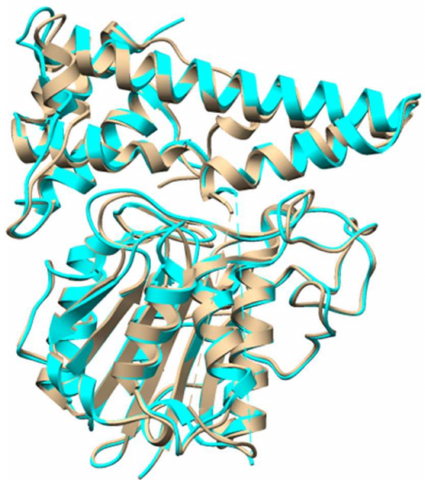
Figure 13. Crystal structure of butelase 1 (tan, PDB 6DHI) overlaid with structure of conventional AEP from Oldenlandia a ffi nis (cyan, PDB